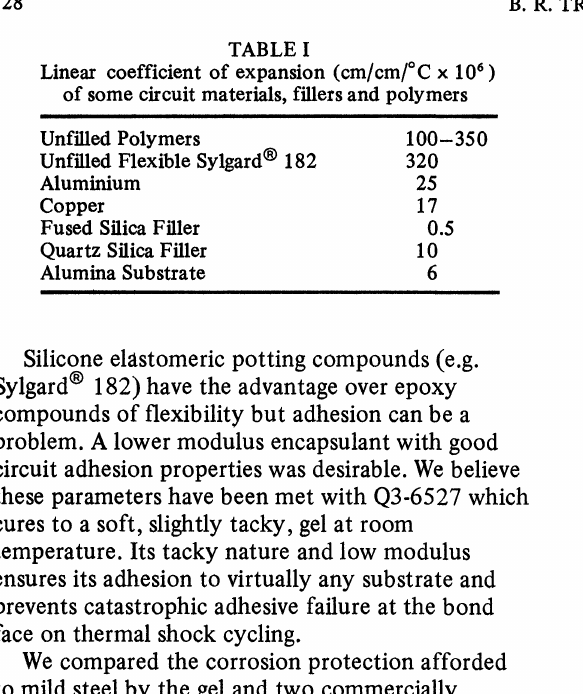
TABLE II Comparison of the corrosion rate of mild steel protected with silicone gel and 2 elastomeric silicone